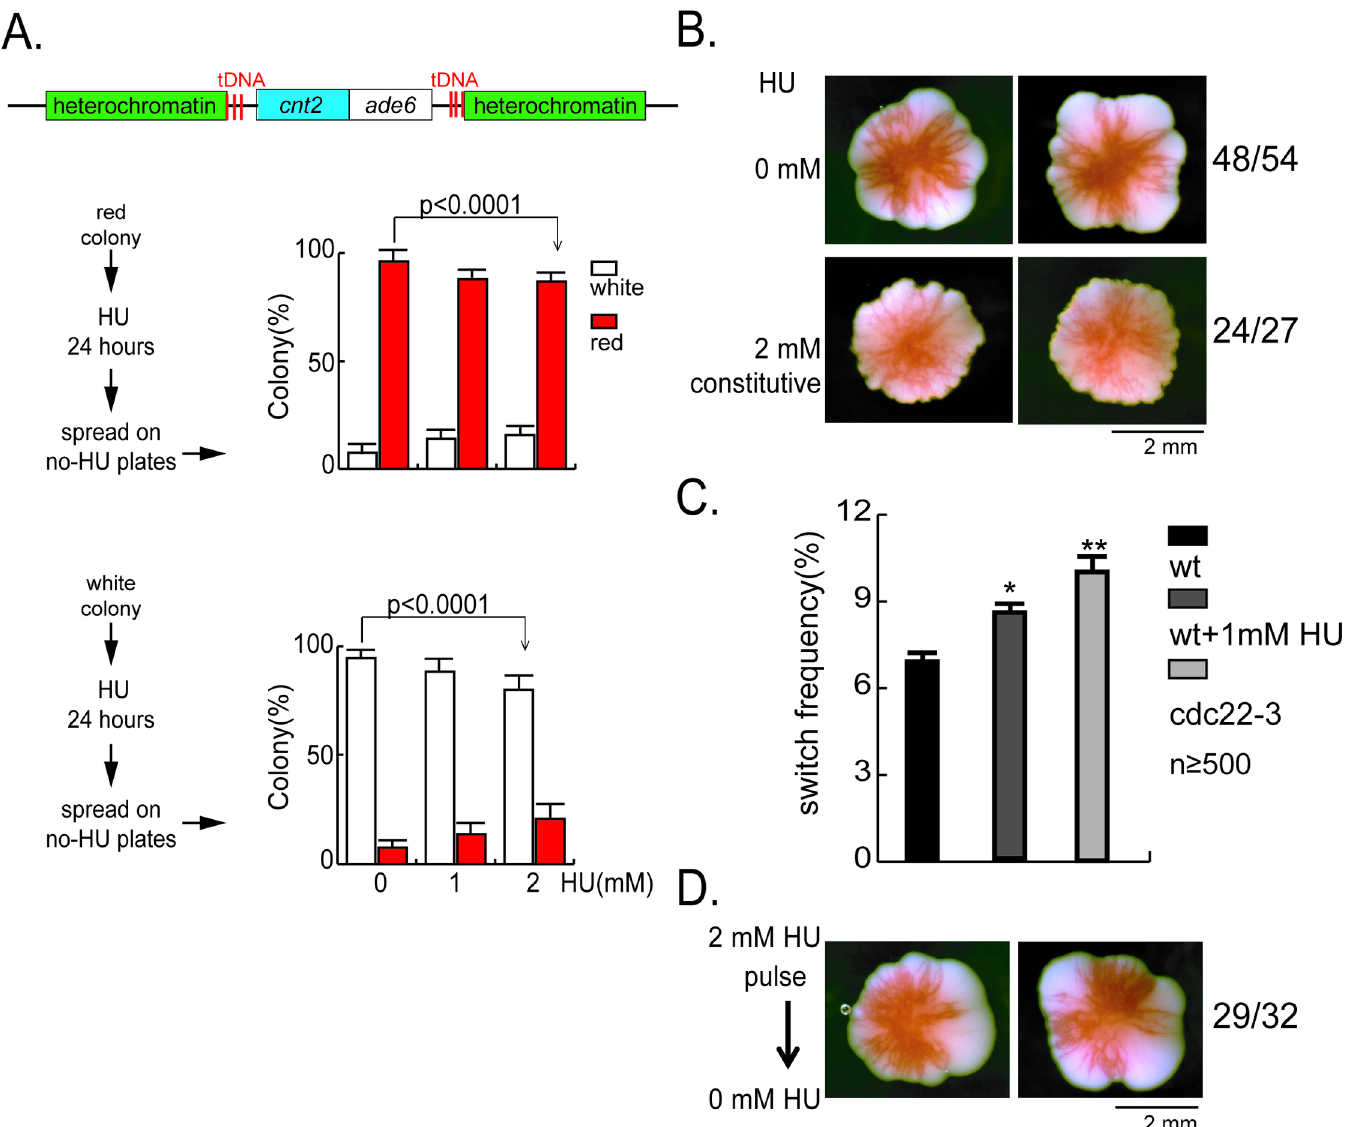
Fig 1. Hydroxyurea (HU) treatment enhances centromeric PEV. (A) HU promotes switching in expressionstates of cnt2 :: ade6 + in a dosage-dependent manner. Cell suspensionsof a red (upper panel)or a white (lower panel)colony are grown in liquidmedia with HU as labeledfor 24 hours, washedand spread onto YE+4S (low adenine)plates, with > 500 cells/plate.The red or white coloniesare counted at 5th day when incubatedat 25˚C. Each experiment has been performed by at least triple biologicalrepeats. Each biologicalrepeat has its uniquecomposition of red/whitecell ratio in the initial culture. One biologicalexperiment result is shownhere. The error bars are 1 SD of percentages for four plates. p values are calculatedby Fisher exact test. (B) The red colony exhibits enhanced sectoringpattern upon HU treatment. Cells derived from the abovered colony (before HU treatment) are plantedevenly at one cell/ cm 2 by microscopic manipulation on YE+4S plates containingHU as labeled,incubatedat 25˚C for eight days. Two representative coloniesfor each are shown. The numbershown here means the number of red coloniesin the total colonies. (C) Elevatedfrequencies of cnt2 :: ade6 + red-to-whiteswitching measuredby pedigreeanalysisin wild type cells with HU treatment and cdc22-3 mutants. Pedigreeanalysesare performed on “hybrid” plates for measuring switchingrate of HU treated cells, each with a drug-free zone and a drug-containing zone. For each pedigree,three cell generationsare tracked at the zone containingHU as labeled.The eight progeny cells are then moved to the drug-freezone, incubatedat 25 ˚ C for five days. For each experimental condition (wild type with or without HU treatment and cdc22-3 mutant), colony color switchingevents are scored in 400–1000 cell divisionevents in total. The error bars are 1 SD of percentages for four independentexperiments. (D) Coloniesmaintainthe wild type level of sectoring after short-term HU treatment. Cell suspensionsof a red colony in (A) grown under 2mM HU is washed and plantedevenly at 1 cell/cm 2 in YE4S media, and incubatedat 25˚C for eight days.